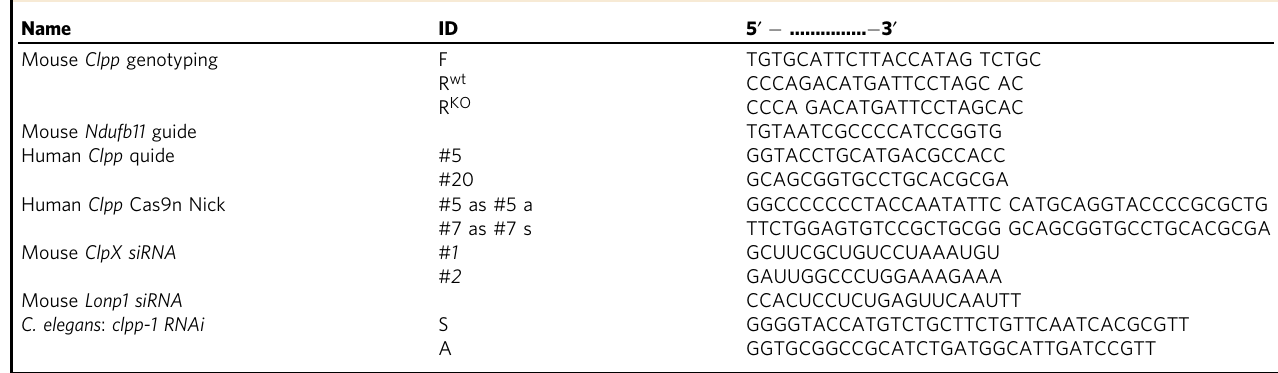
Table 2 Primers and oligonucleotides. Name